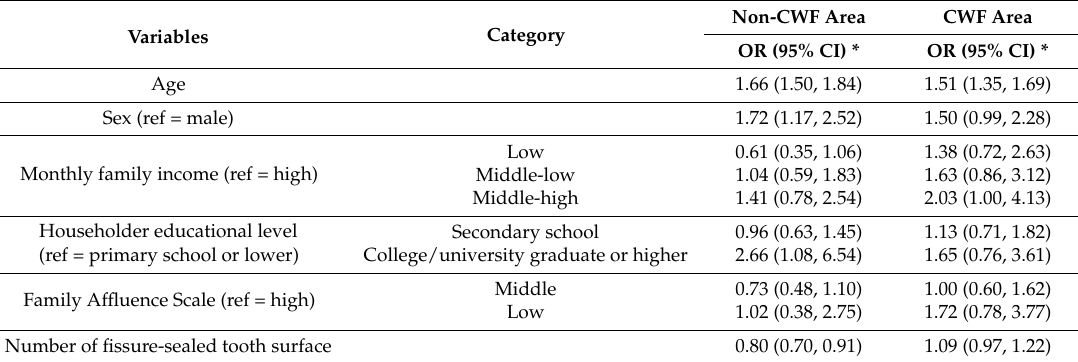
Table 4. Odds ratio (OR) of caries experience adjusted for related variables.